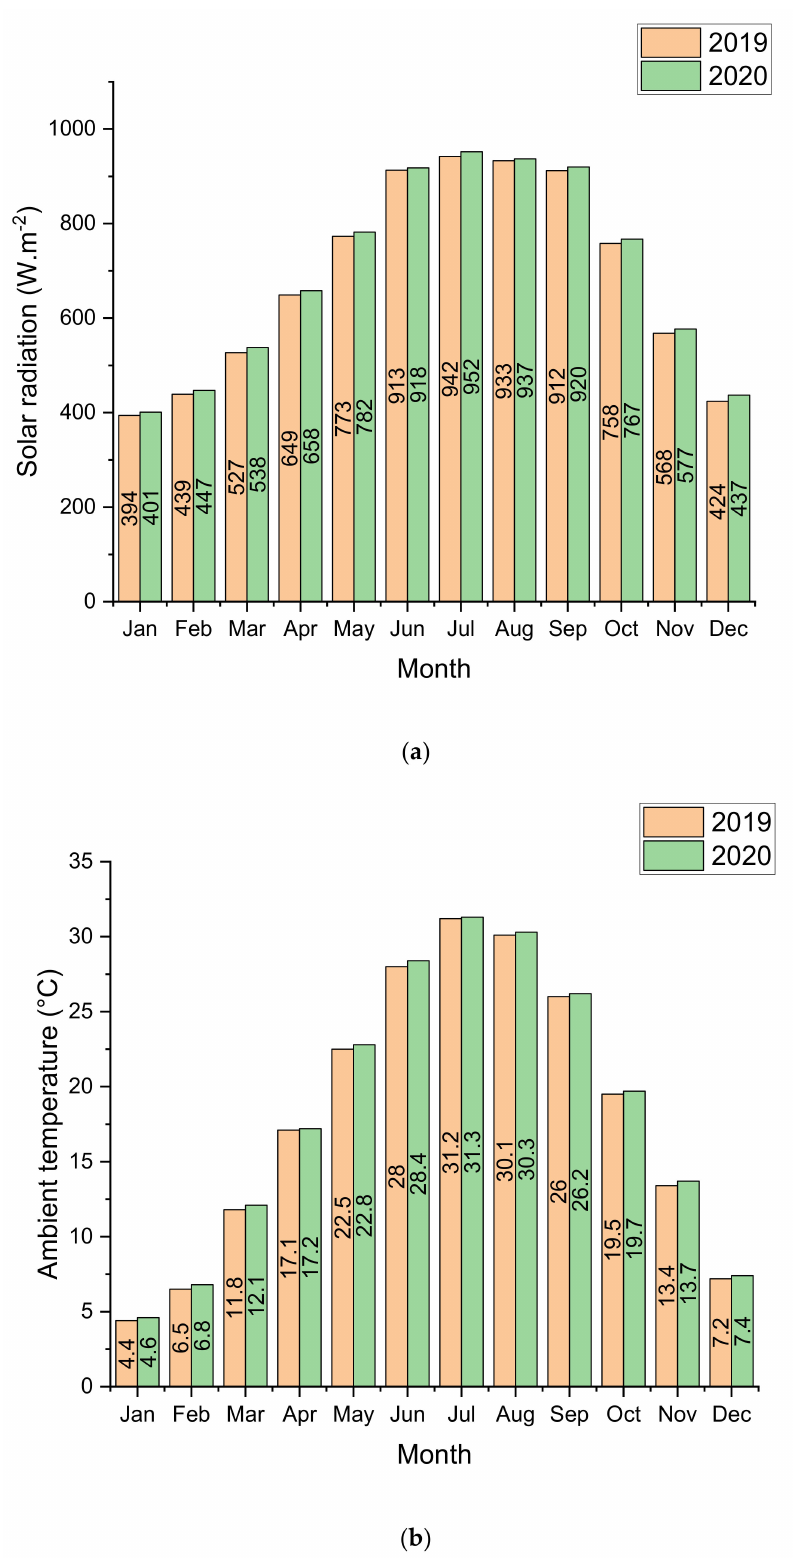
Figure 2. Annual profiles of meteorological characteristics on the experimental days; ( a ) solar radiation; ( b ) Average ambient